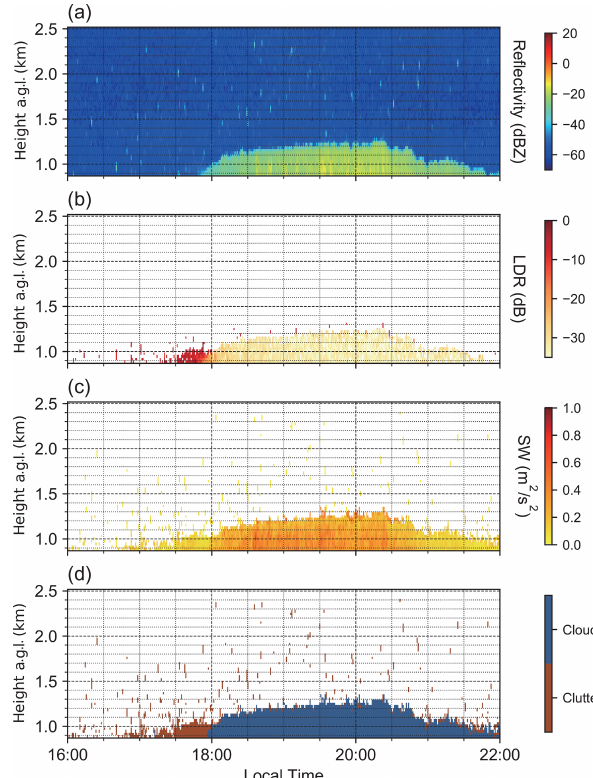
Figure 13. Same as Fig. 8 but for 16:00 to 22:00LT on 4 February 2014. Note that the lidar observation is missed that